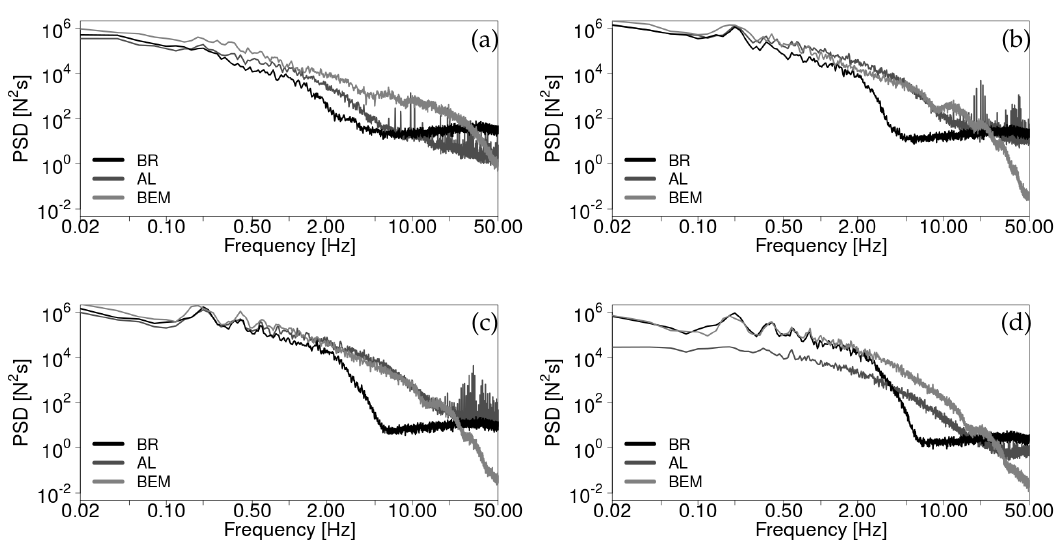
Figure 7. Power Spectral Density (PSD) of axial forces at ( a ) 22.5%; ( b ) 50%; ( c ) 75% and ( d ) 95% radial position.